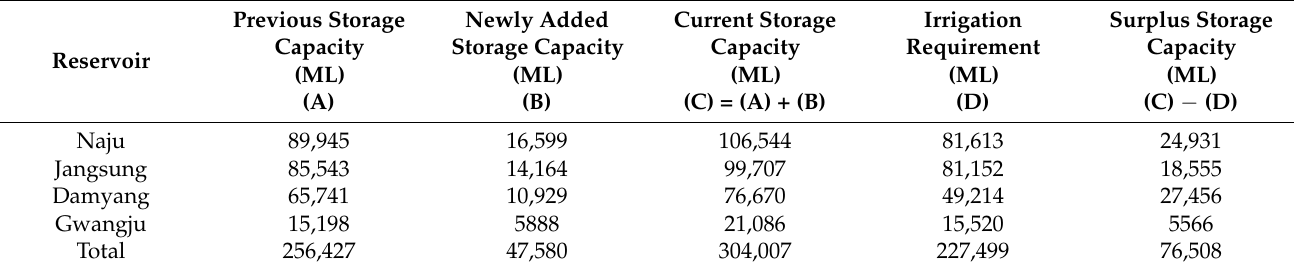
Figure 5. Daily variations in the amount of water stored in the reservoirs, planned and actual EF supply. Table 3. The estimated amount of water that each of the reservoirs can store after the dam